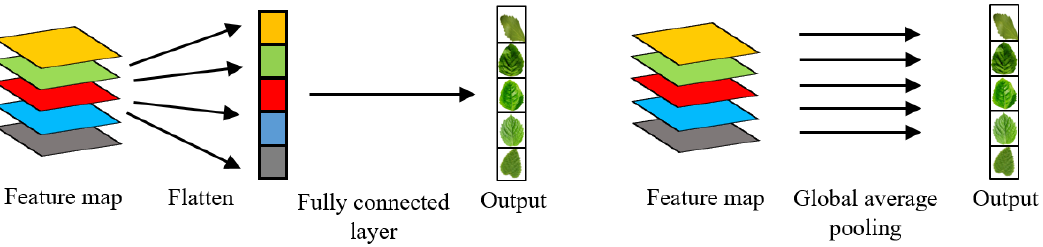
Figure 5. Differences in the performance of GAP vs. fully connected layers in imaging classification.